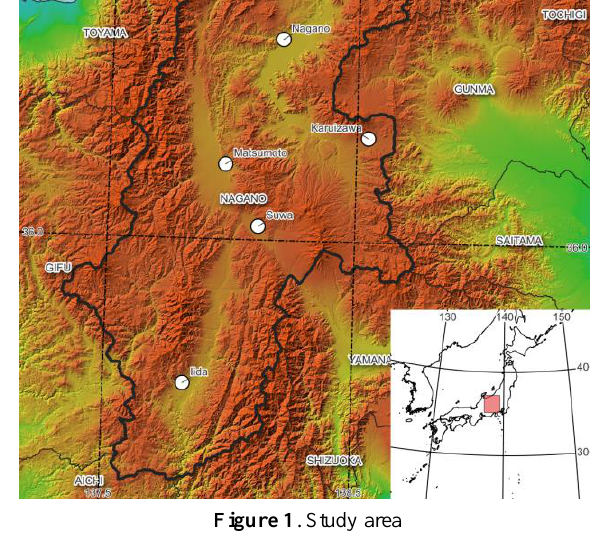
Figure 1 . Study area